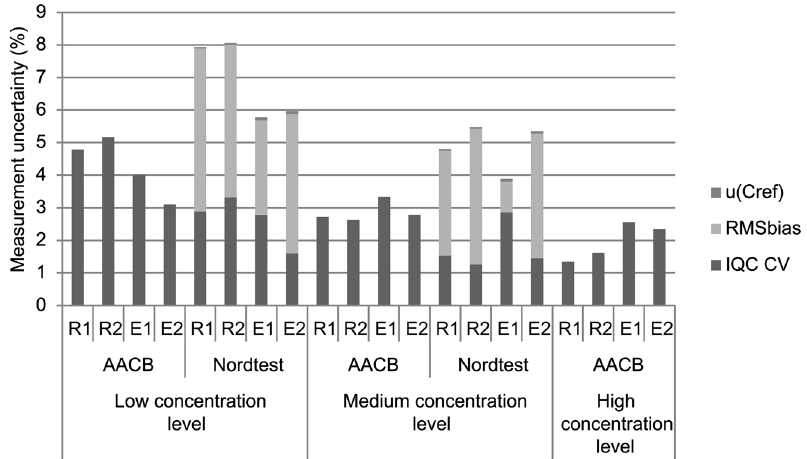
Figure 2: Measurement uncertainty of WBC of four autoanalyzers with two different guideline, with contribution rates of RMS bias , u ( c ref ) and imprecision of IQC. AACB, Australasian Association of Clinical Biochemists Uncertainty of Measurement Working Group Measurement Uncertainty Guideline; Nordtest, Handbook for Calculation of Measurement Uncertainty in Environmental Laboratories Guideline; u ( C ref ), uncertainty of external quality assurance sample; RMS bias , root mean square bias; IQC CV, imprecision of internal quality control; R1 and